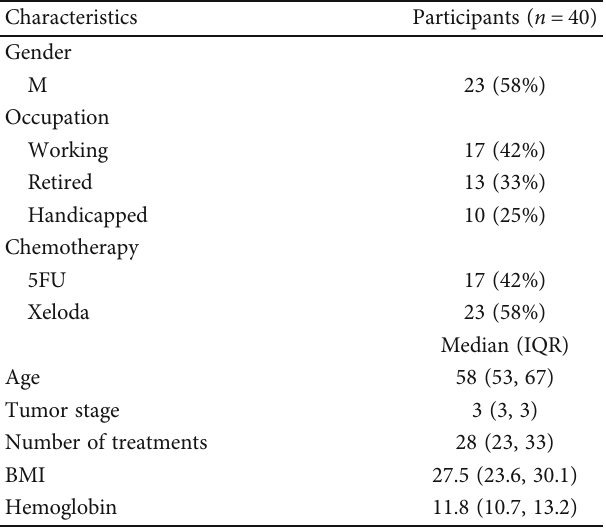
Table 2: Study participants ’ ( n = 40 ) demographic and clinical characteristics.